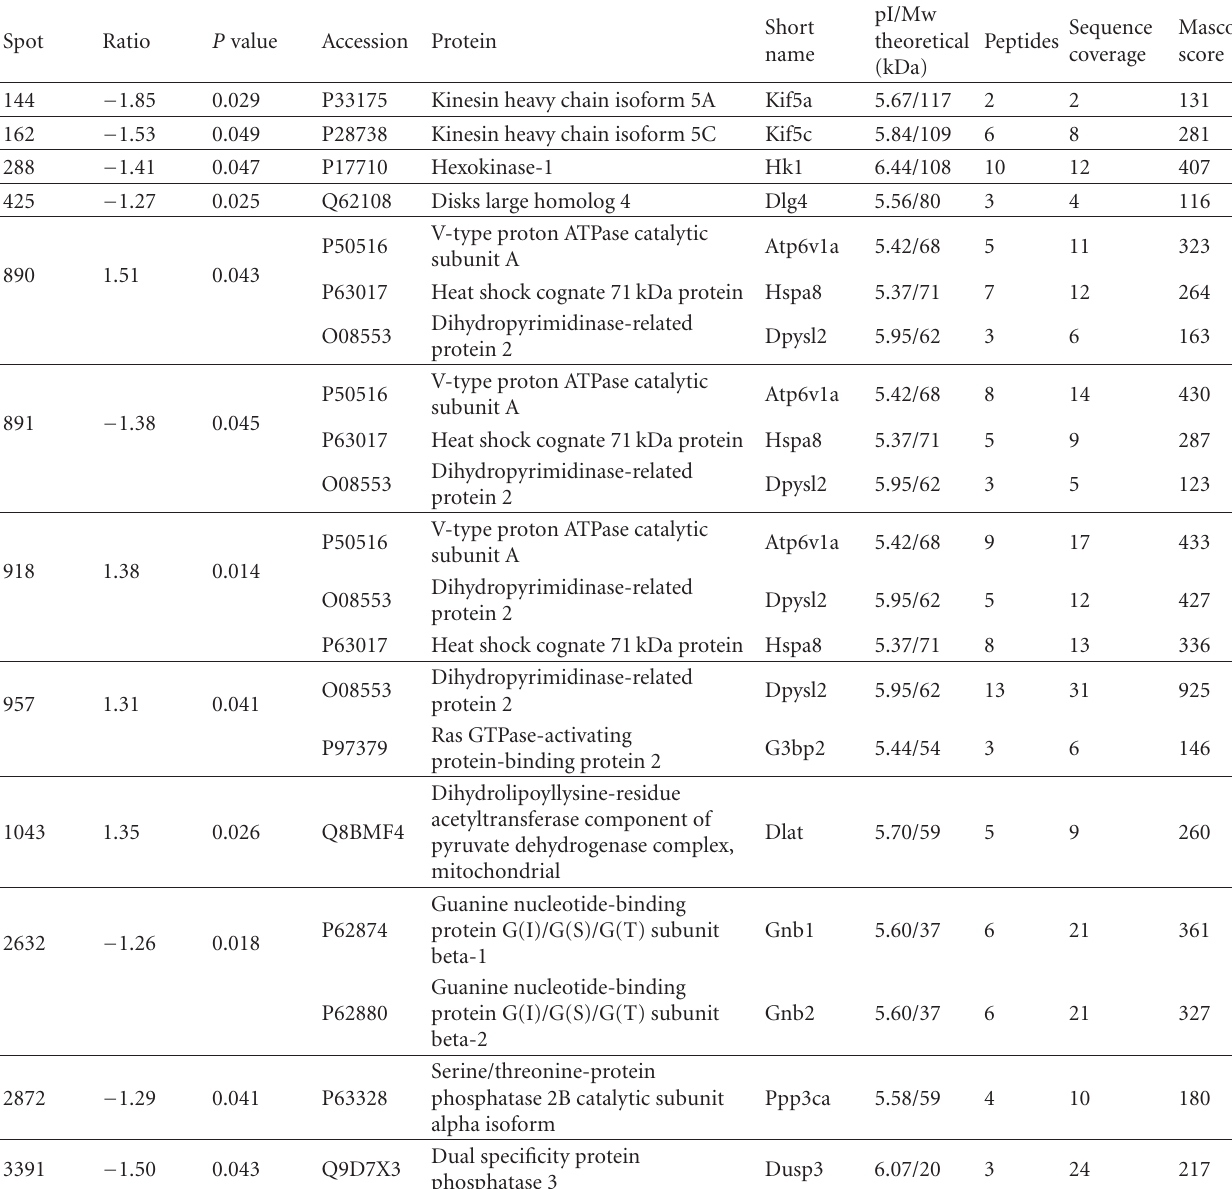
Table 1: Relative expression and nanoLC-ESI-LIT-MS/MS-based identification of di ff erentially expressed proteins, as revealed by 2D-DIGE analysis of synaptosomal